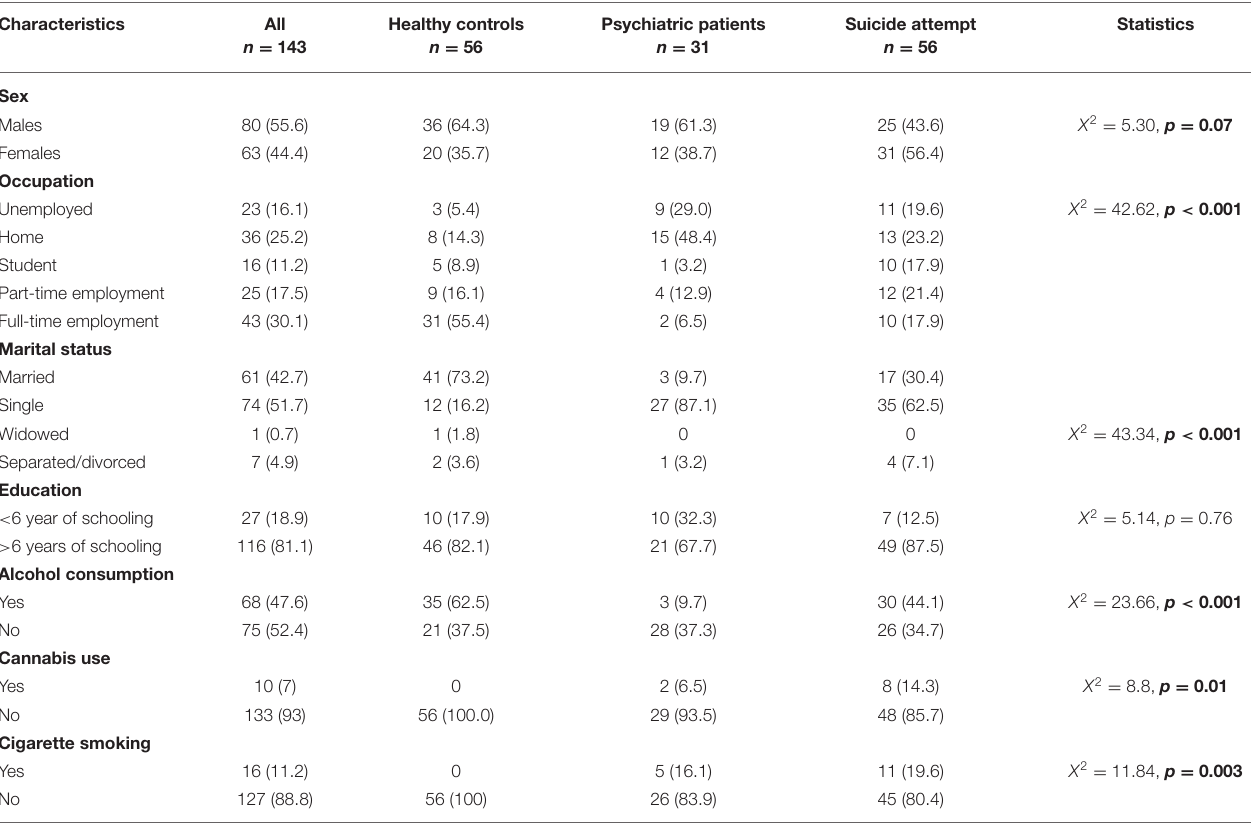
TABLE 1 | Sociodemographic characteristics of suicide attempters, patients with psychiatric diseases and healthy individuals in a Mexican population. Characteristics